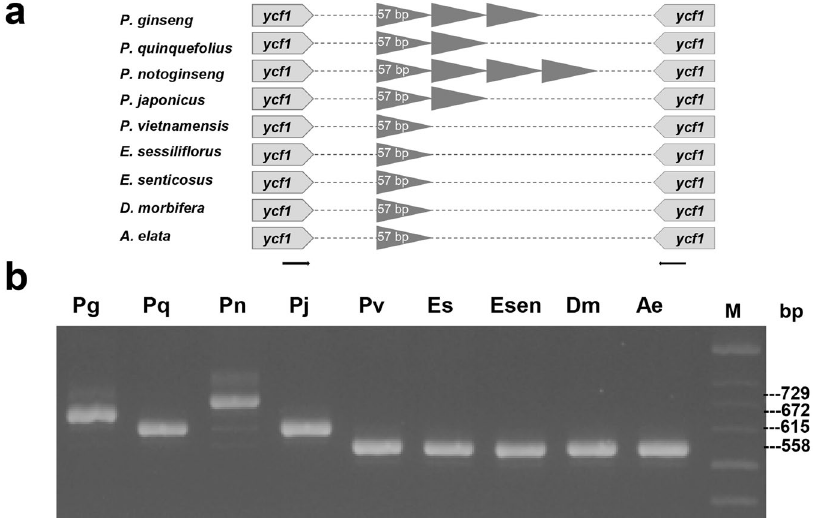
Figure 3. Validation of polymorphic sites with TR CNV in cp genomes of Araliaceae species. ( a ) Schematic diagram of CNV of TR units found in ycf1 genes among nine species, and triangles indicate TR unit of 57 bp. ( b ) Validation of CNV of 57-bp TR in nine species using genomic DNA PCR analysis with the pgycf01 primer set (Supplementary Table S2). Abbreviated species names (Table 1) are shown above the lanes. M indicates 100-bp DNA ladder.